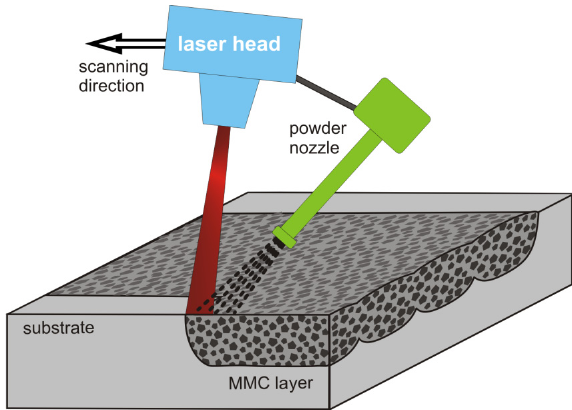
Figure 1. A schematic drawing of the principle of formation of the MMC layer by the laser dispersing process.